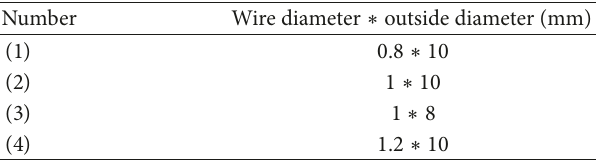
Table 2: Various sizes of the